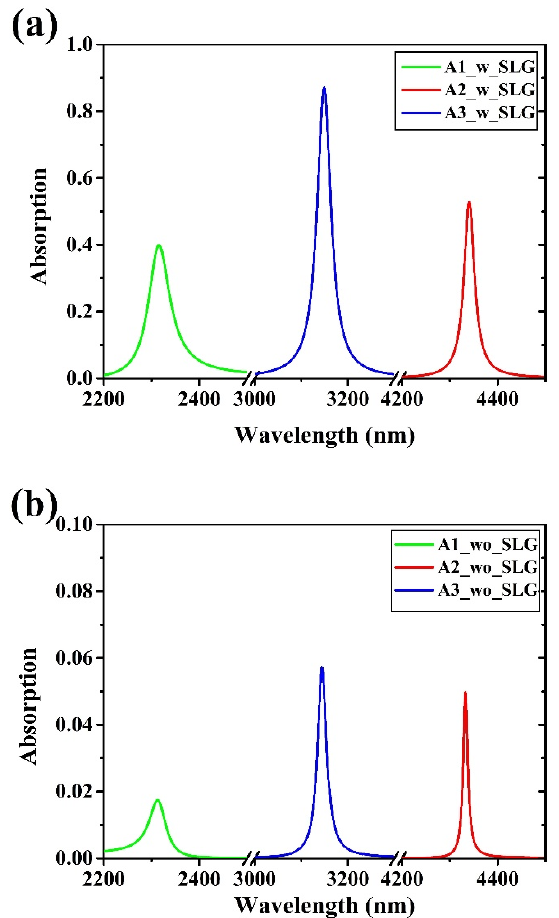
Figure 5. ( a ) Simulated absorption curves of SLG inside the Fabry–Perot filters in case of symmetric FP1 (A1), asymmetric FP2 (A2), and asymmetric reflective FP3 (A3). ( b ) Simulated absorption of FP filters without graphene insertion.